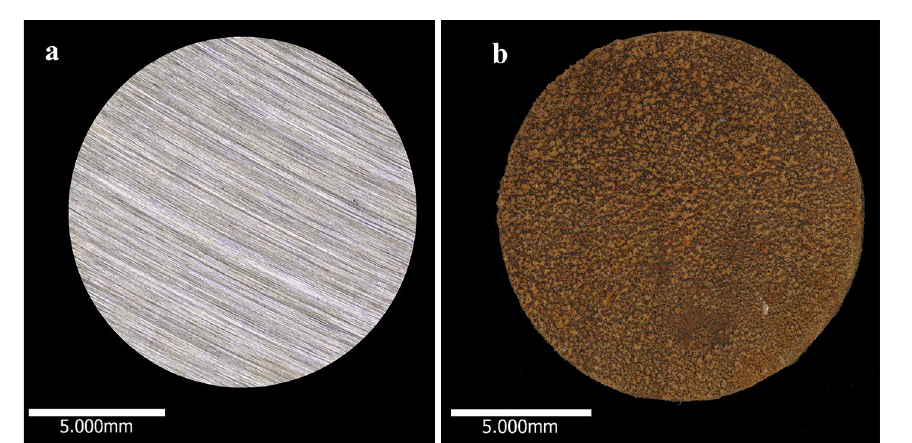
Figure 2. Micrographs of the entire wet-ground surface ( a ) and oxidised surface ( b